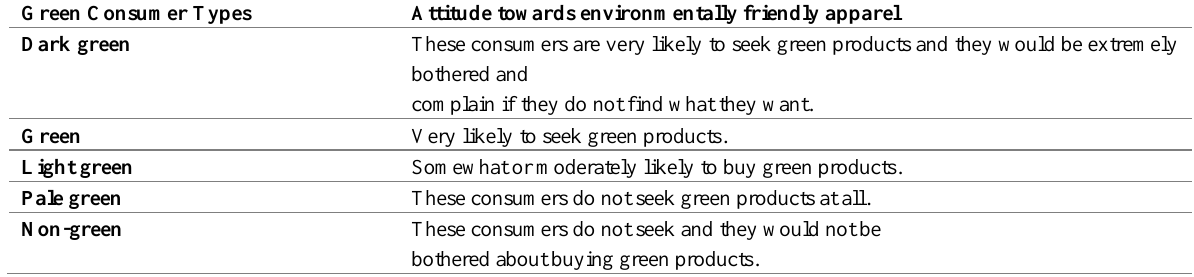
Table 1: The spectrum of green